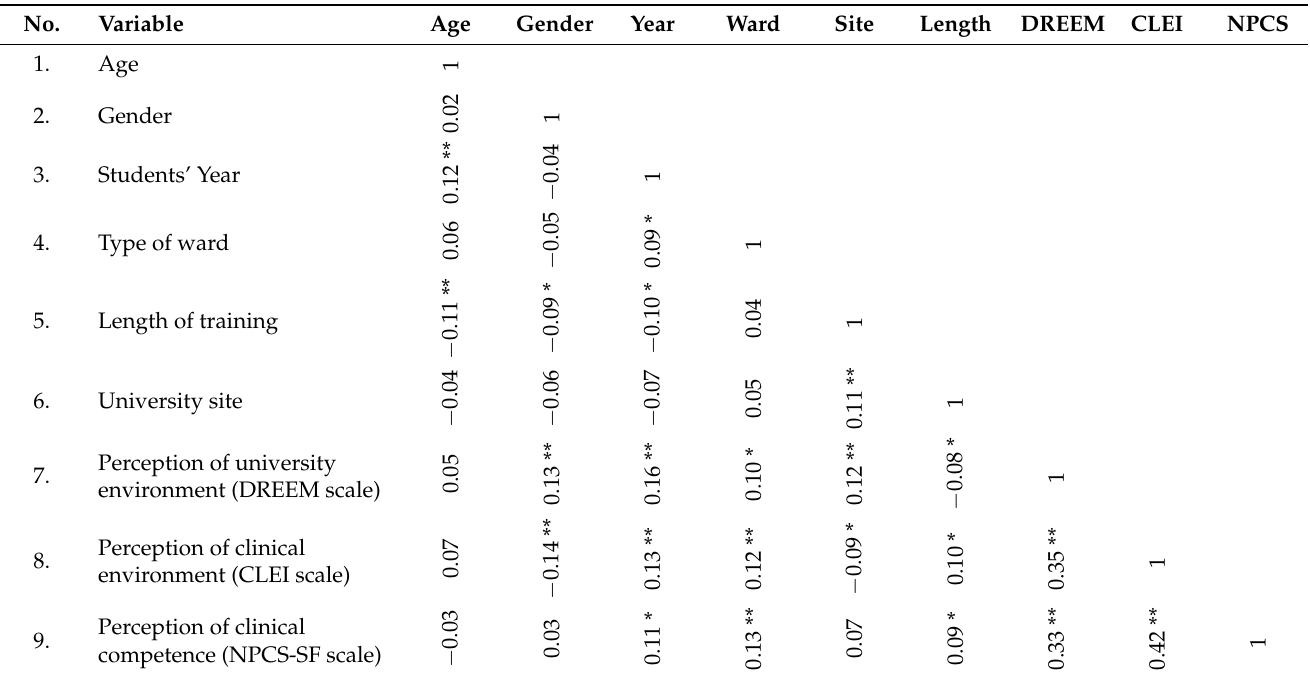
Table 3. Main study variables correlation matrix (N =